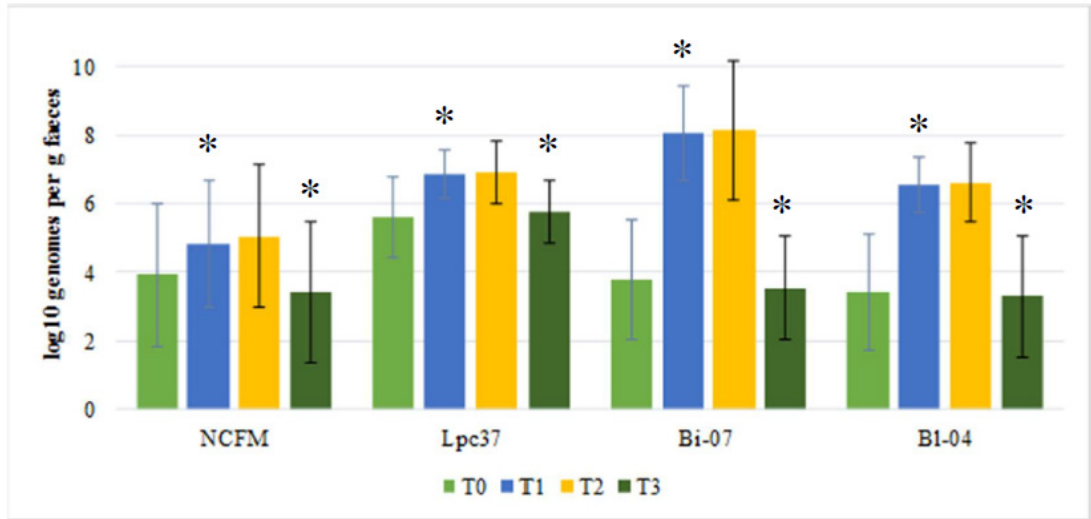
Figure 2. Mean levels ( ± SE) for Log10 detected genomes per gram feces for the three target strains; Lactobacillus acidophilus NCFM, Lactobacillus paracasei Lpc-37, Bifidobacterium lactis Bi-07, and B. lactis Bl-04 in the probiotic group for the four sampling times. Where T0 = baseline, T1 = end of antibiotic treatment, T2 = end of probiotic treatment, and T3 = one week after end of probiotic treatment (washout). * Indicates significant changes from previous time point.